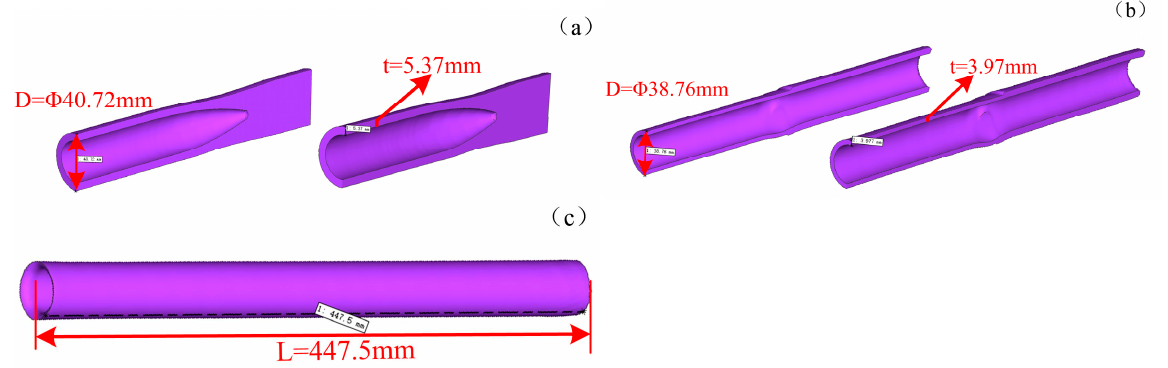
Figure 6. Different stage dimensions: ( a ) tube after piercing; ( b ) tube after rolling and ( c ) total length after the TSR process.